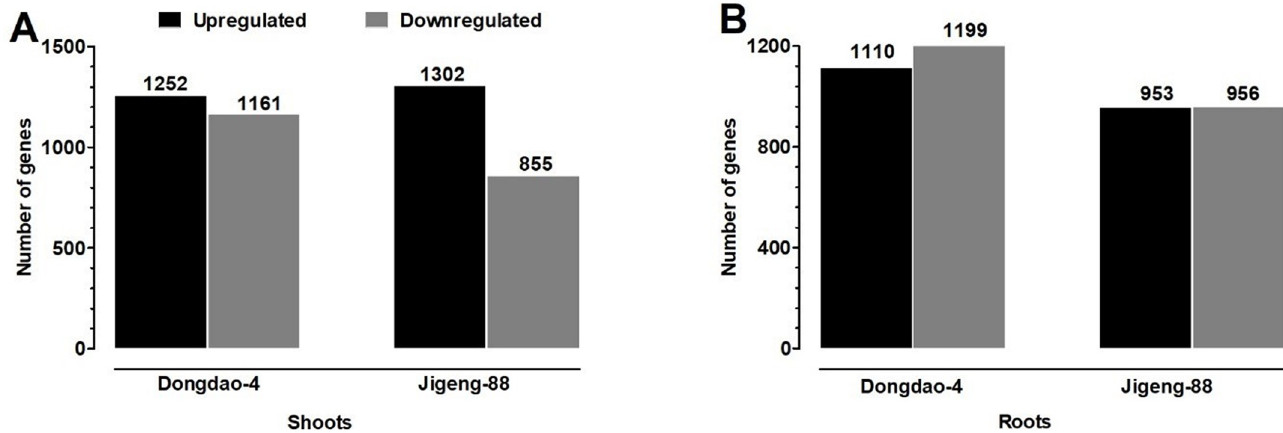
Fig 2. Summary of the numbers of differentially expressed genes upon exposure to saline-alkaline stress in Dongdao-4 and Jigeng-88. (A) The number of genes up- or downregulated in shoots of Dongdao-4 and Jigeng-88. (B) The number of genes up- or downregulated in roots of Dongdao-4 and Jigeng-88.